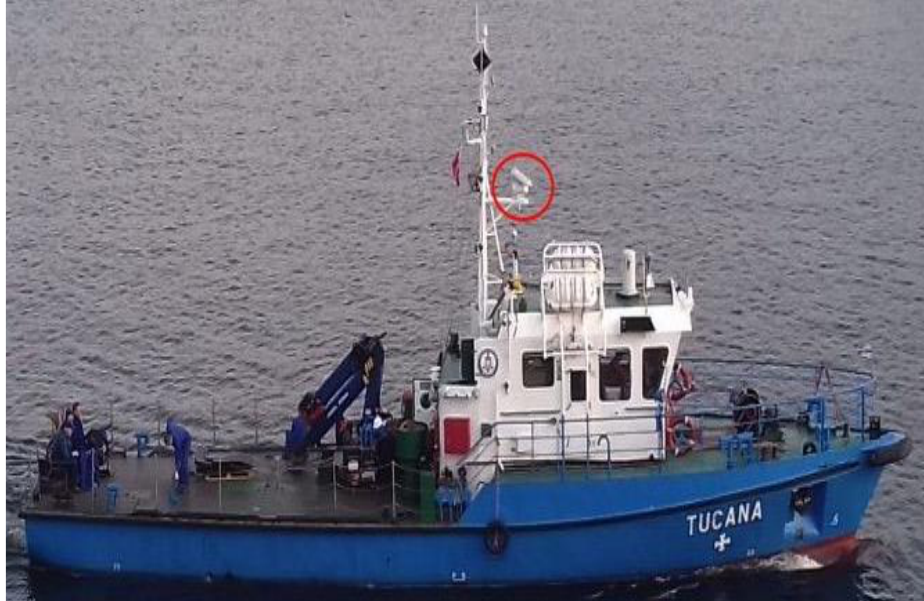
Figure 9. Hydrographic vessel m/s TUCANA with the SRN T44X radar antenna (red circle marked).